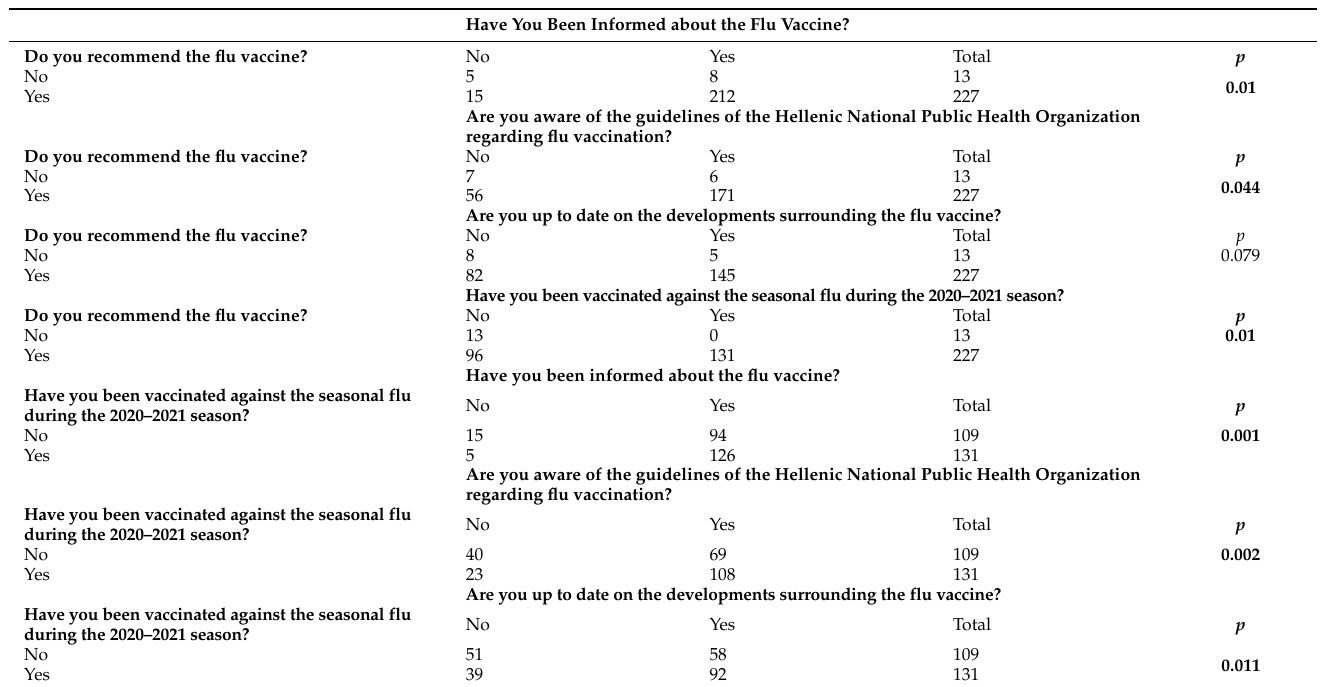
Table 7. Associations between information about the flu vaccine and vaccine recommenda- tion/vaccination of the healthcare